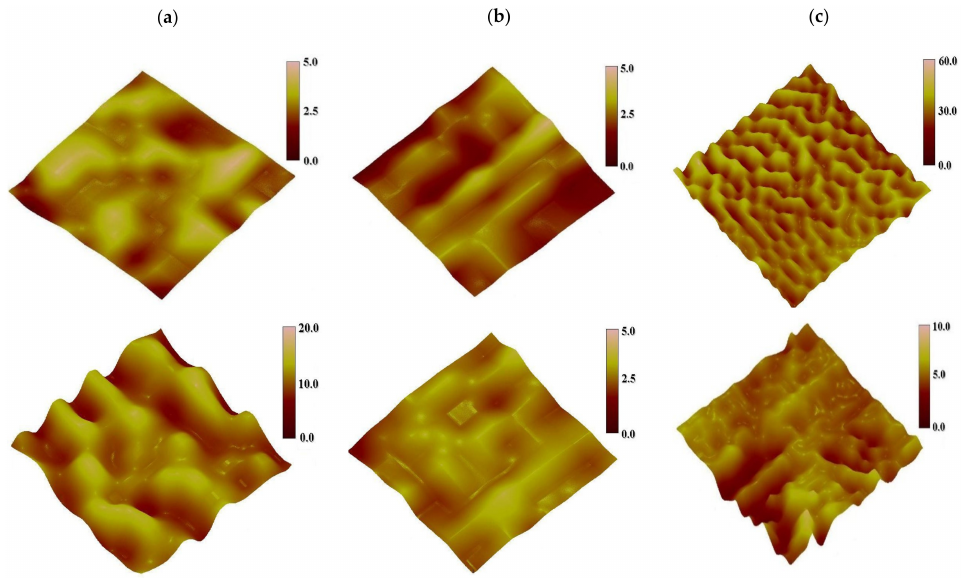
Figure 9. The surface height images of coatings not-immersed (up) and immersed (down) in seawater, ( a ) PEG0, ( b ) PEG50, ( c ) PEG100, tap mode, region of 1 µ m × 1 µ